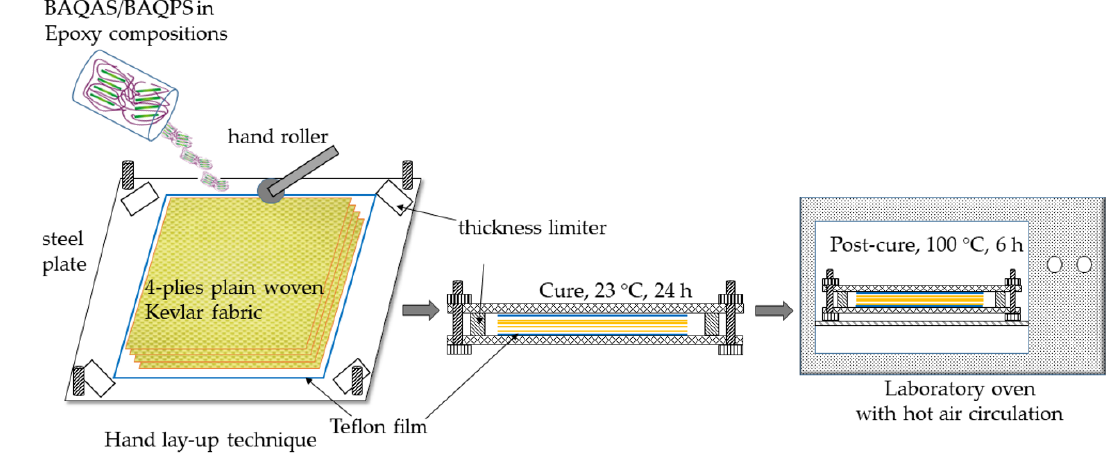
Figure 1. A schematic diagram of KFCs fabrication procedure.